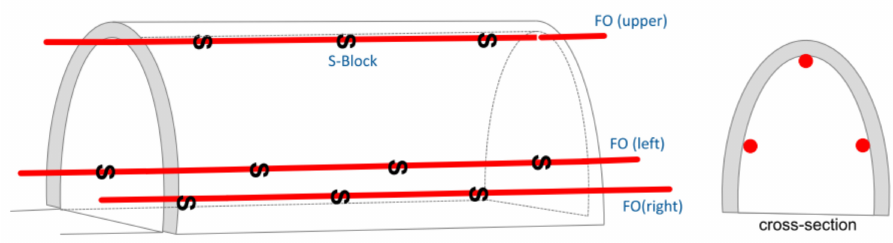
Figure 4. Example layout of DFOS strain sensors for displacement calculations of tunnel lining (for 3D calculations, at least three fibres are required)